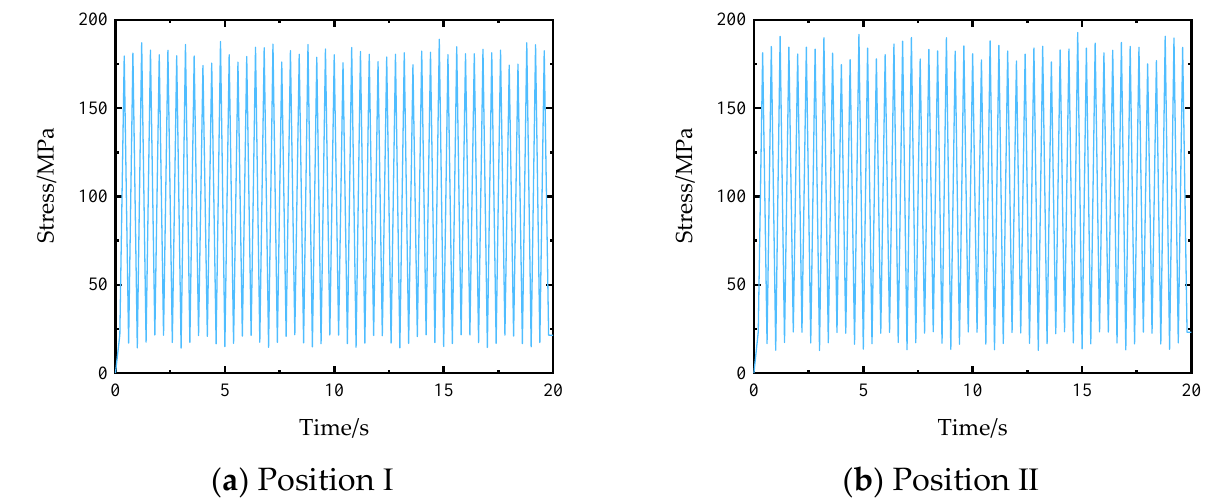
Figure 14. The maximum stress in the X direction of the yarn at different meso-model positions. Table 6. Fatigue analysis results of 2D SiC/SiC stiffened plates with different meso-model positions.